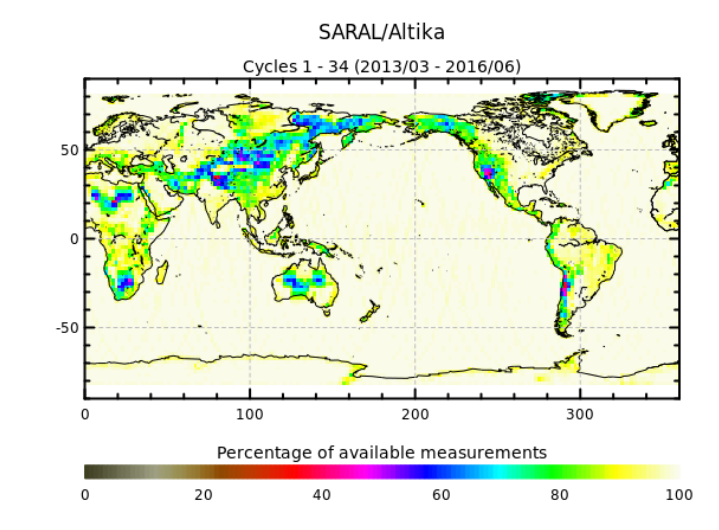
Figure 11. Map of the percentage of available measurements over land on SARAL/AltiKa’s cycles 1 to 34.